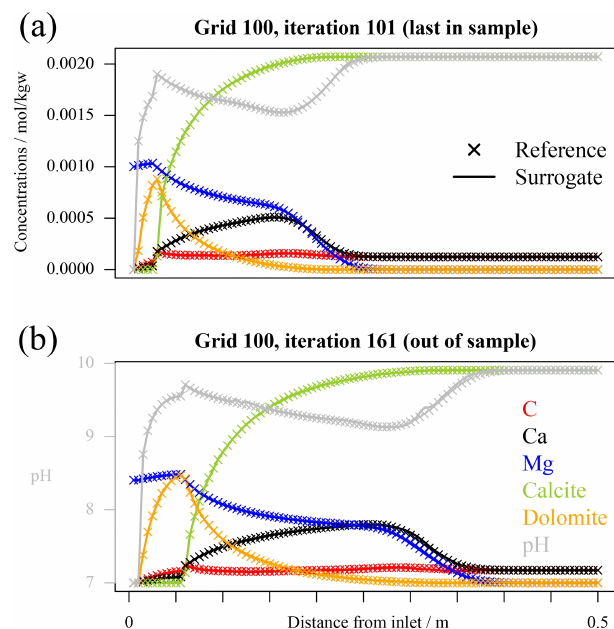
Figure 2. Profiles of total concentrations, pH, and minerals for ref- erence and hierarchical coupling 1D simulations with tolerance on mass balance error set to 10 − 6 for grid 100. The axes are anno- tated in these figures: all aqueous and mineral concentrations are given in terms of moles per kilogramme of solvent, while pH in its adimensional units. (a) The last in-sample time step; (b) the last simulated time step after 60 iterations for which the surrogate was